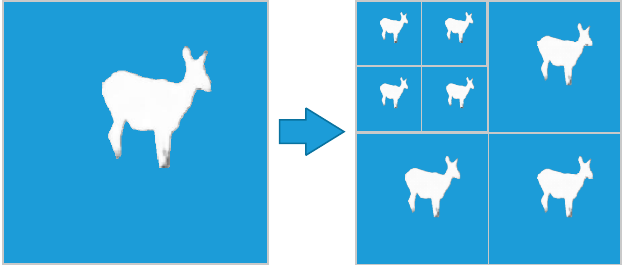
Figure 7. Mask update with wavelet decomposition. Left : The mask of saliency object region. Right : Mask update of three level wavelet decomposition.